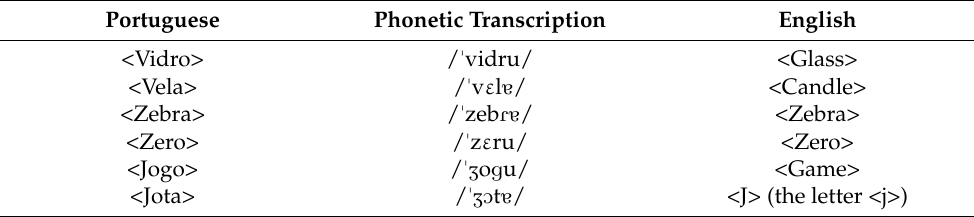
Table 1. List of words with the voiced